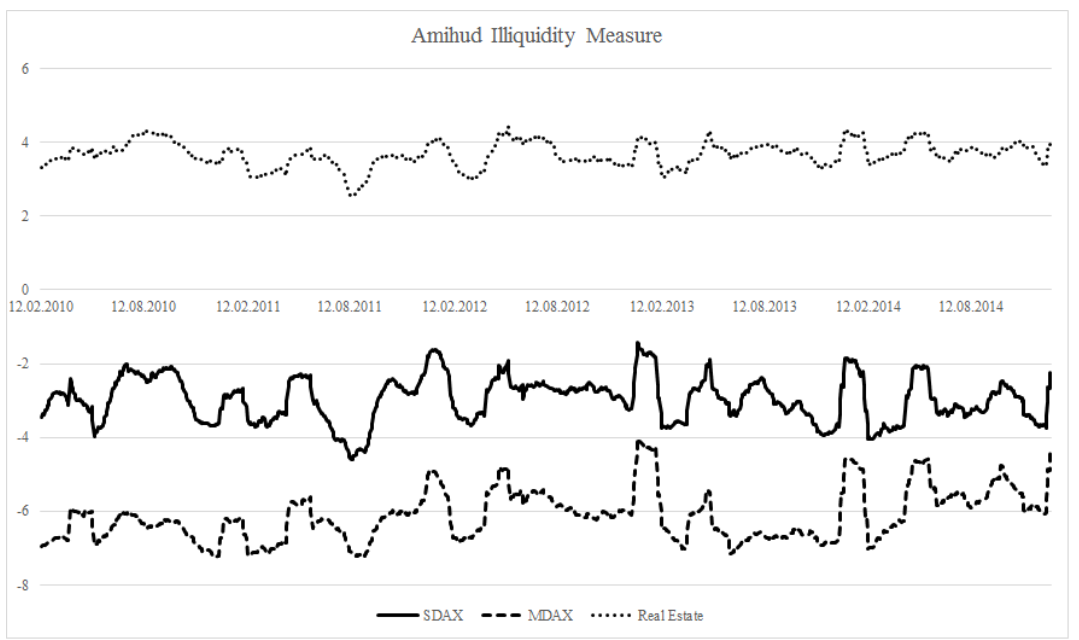
Figure 4. Estimates of rolling window Amihud illiquidity coefficients. The figure is a graphical representation of rolling window Amihud illiquidity coefficients averaged for the sub-samples of real estate stocks, as well as the constituents of the MDAX and the